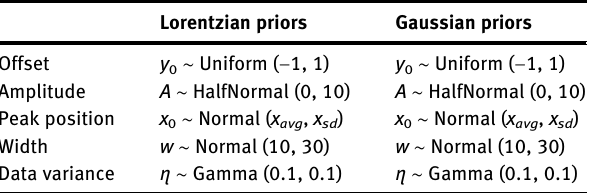
Table  : Priors used in sampling.